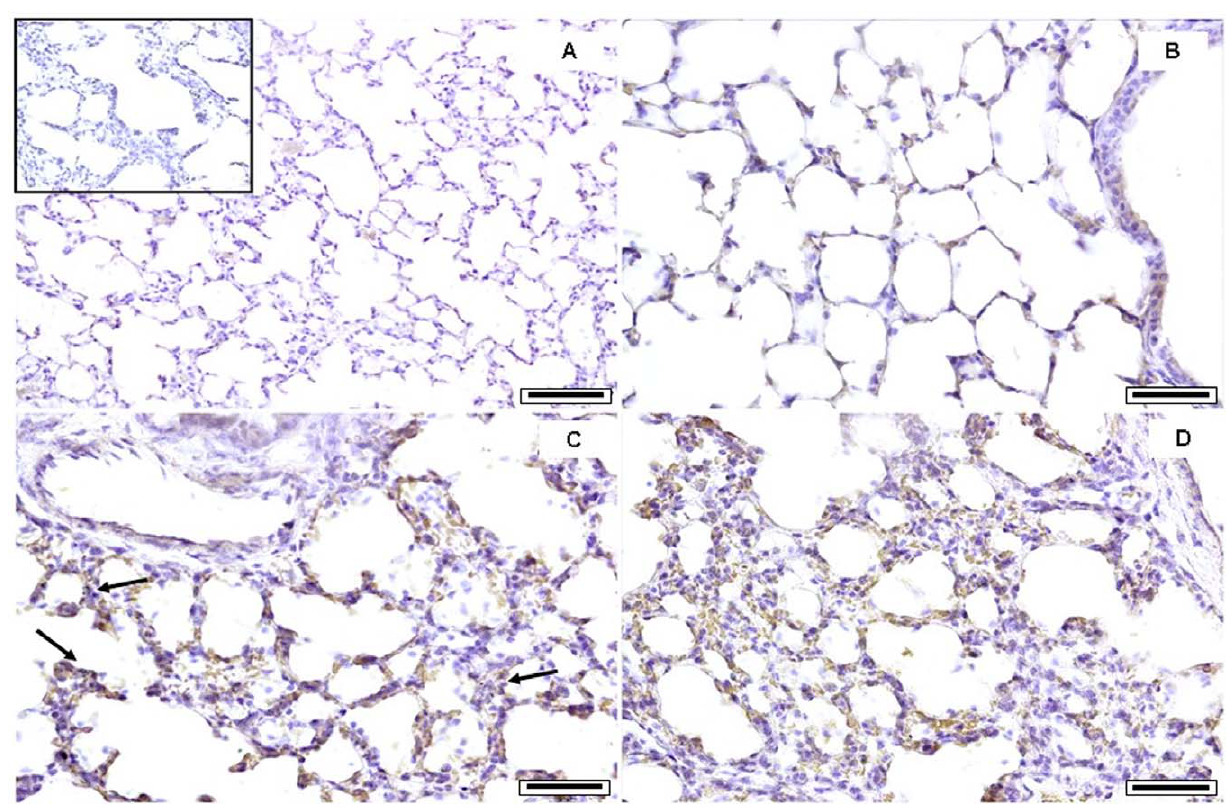
Figure 3. Lung immunohistochemical analysis. Immunohistochemical analyses of HO-1 expression in lung tissue 24 h after the third intratracheal instillation; the brown color reflects the site and intensity of HO-1 expression. (A): lung of sham mice; in the box, a control of the immunohistochemical reaction specificity, where the primary antibody has been avoided, in a PM10sum instilled mouse; (B): alveolar and peribronchiolar spaces in the lung of a sham mouse; (C, D): alveolar and peribronchiolar spaces in lungs of PM10sum-treated mice. Each figure represents the status evidenced examining 6 sham and 6 PM10sum-treated mice. A bar=150 m m; B–D bars=50 m m.